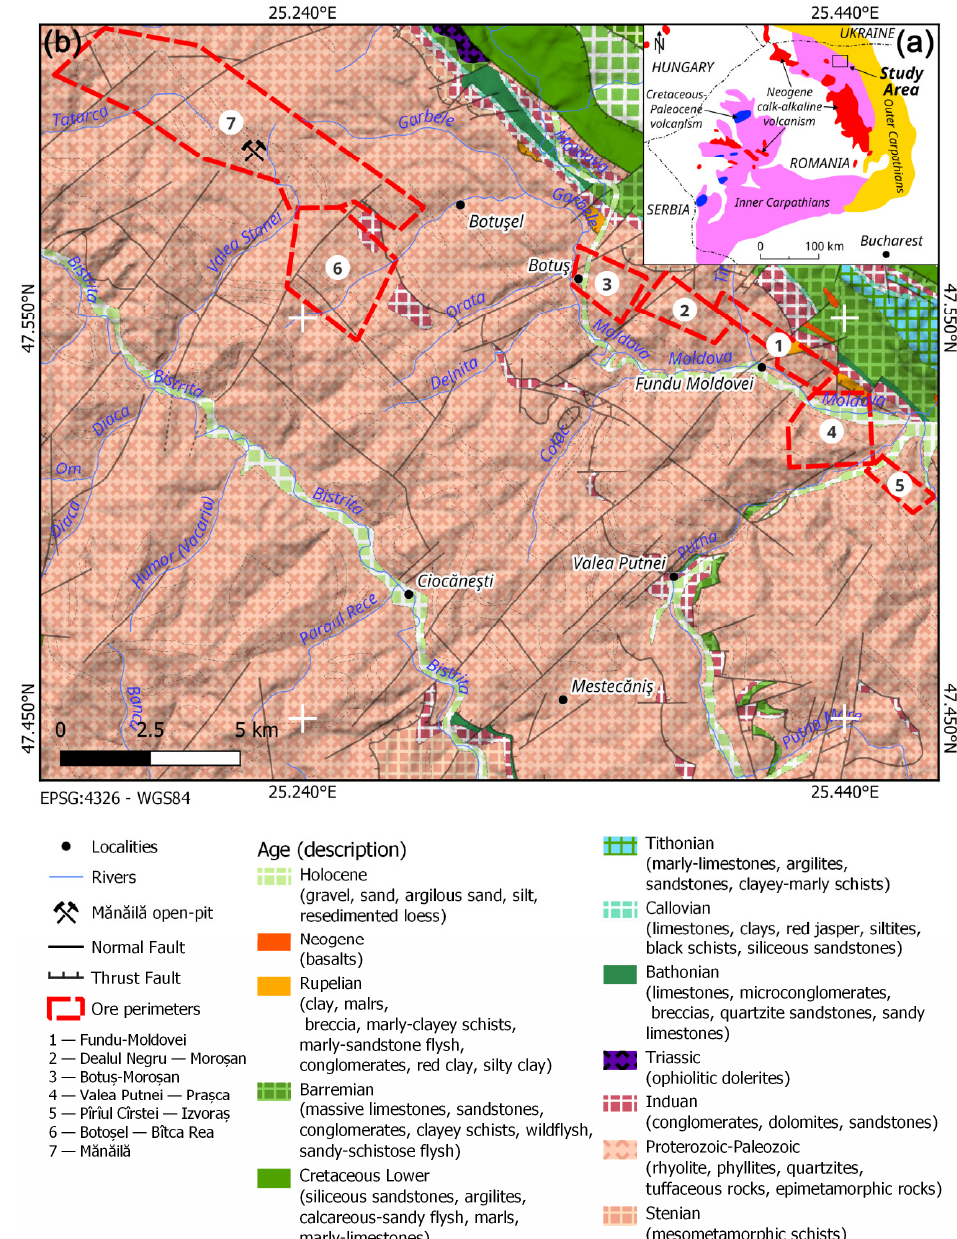
Figure 1. Localization of the studied area in the Carpathians, redrawn after Alderton and Fallick [18] ( a ); geological map of the Fundu Moldovei member with ore perimeters—modified after [19] ( b ). The Tg1 formation is predominantly composed of quartzite sericite and quartzite sericite-chlorite schist over which quartzite and quarzto-feldspathic rocks are